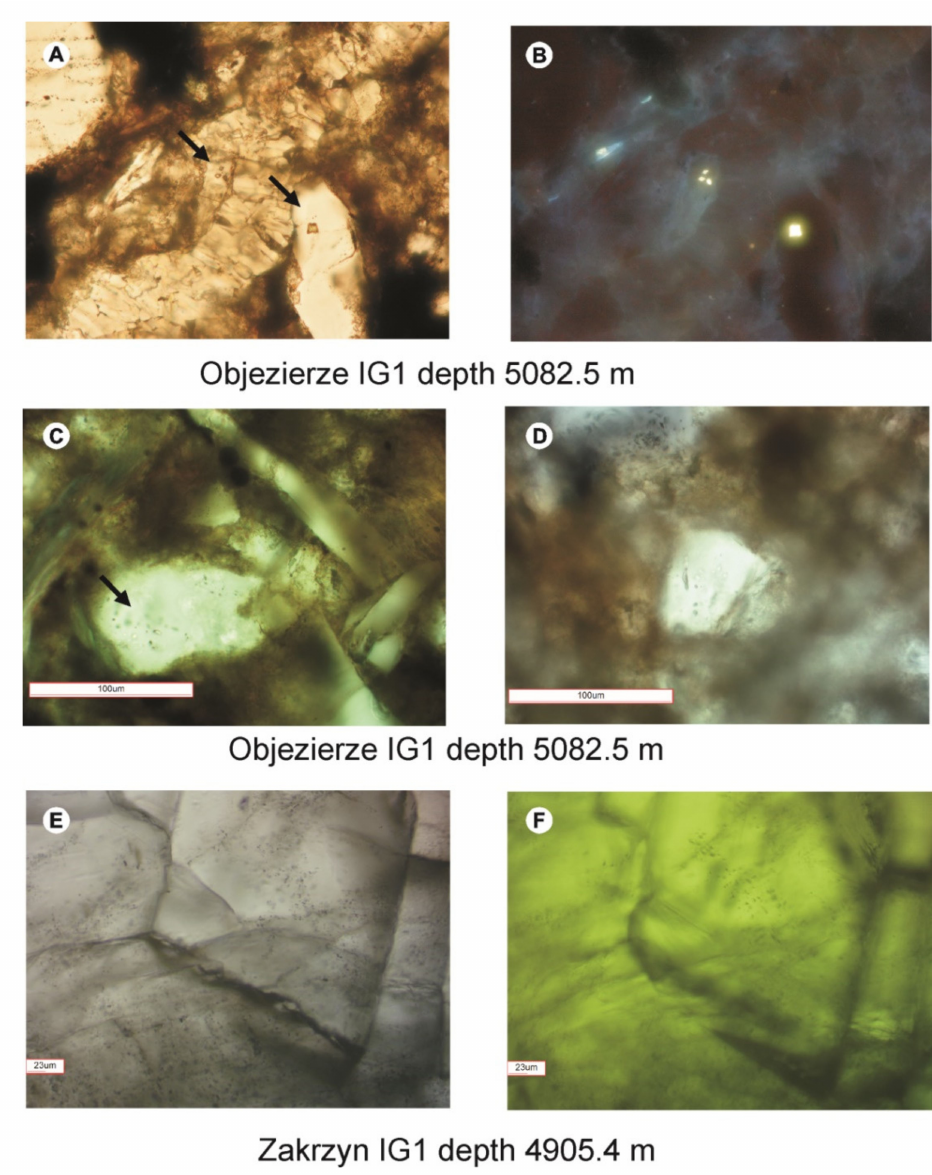
Figure 6. Fluid inclusions in different minerals and boreholes. ( A , B ) The fluorescent yellow fluid in inclusions in vein calcite. ( C , D ) Not fluorescent two-phase inclusions. Objezierze IG 1 borehole, depth of 5082.5 m. ( E , F ) Not fluorescent small inclusions in ankerite. Zakrzyn IG 1 borehole, depth of 4905.4 m. Images in transmitted ( A , C – E ) and reflected ( B , F ) lights. Microthermometric results of the FI studies, both aqueous (AQFI) and hydrocarbon following: T h —homogenization temperature, T e —eutectic temperature, T m —ice